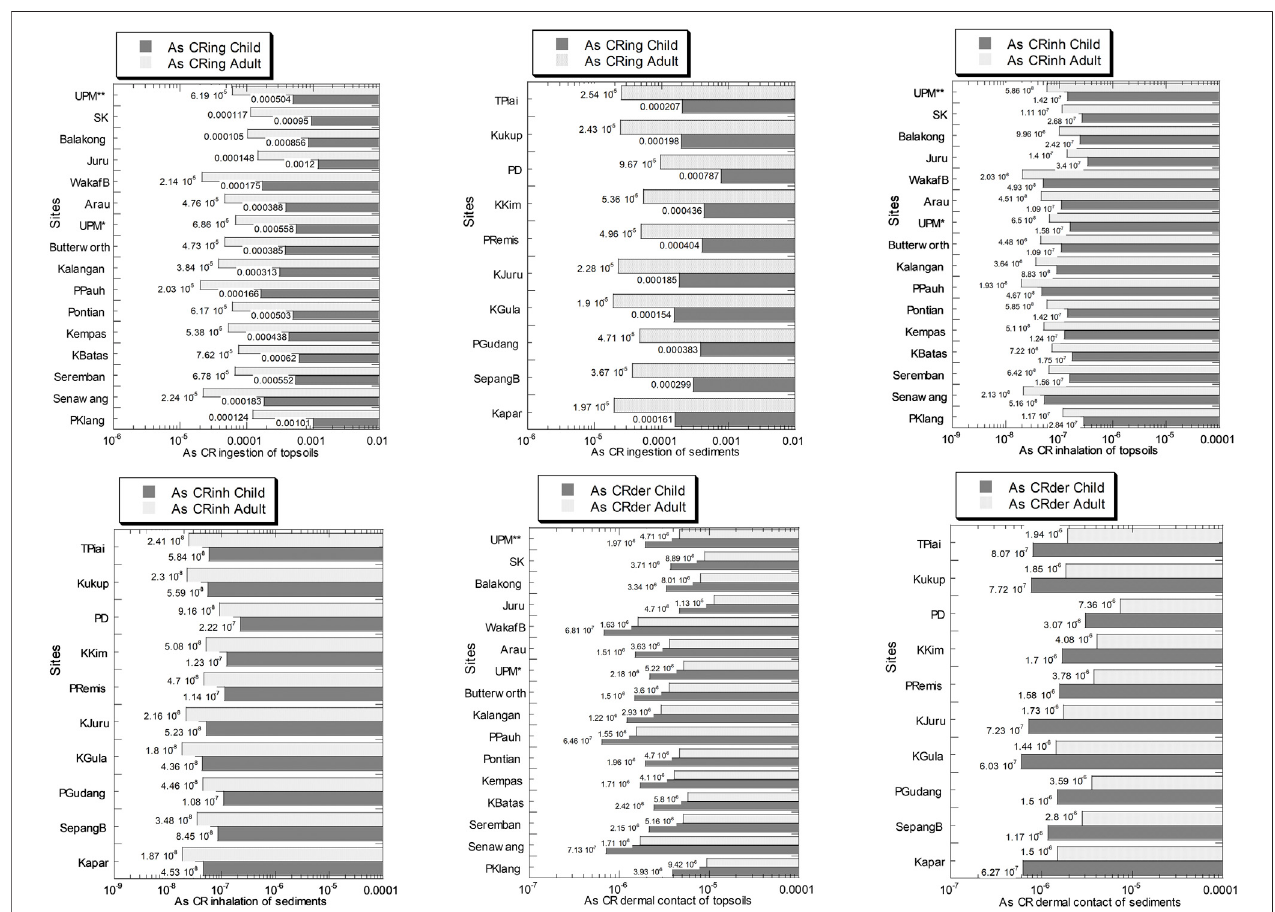
FIGURE 11 | As carcinogenic risk (CR) values of ingestion (CR ing ), inhalation (CR inh ), and dermal contact (CR der ) pathways in the soils (numbers in white circles (1 – 16)in Figure1 ;S1 – S16in SupplementaryTableS1 )andmangrovesediments(numbersinblackcircles(1 – 10)in Figure1 ;M1 – M10in SupplementaryTableS1 ) from Peninsular Malaysia, in children and adults. The X -axes are based on a logarithmic scale.